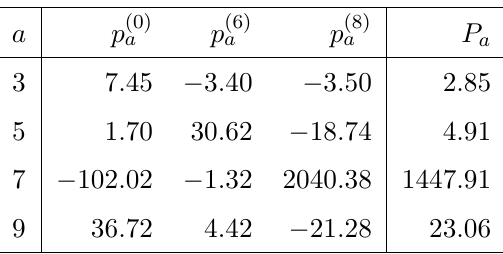
Table 12. Values of the coe(cid:14)cients entering the semi-numerical formula of " 0 =" in eq. (C.29). The last column gives P a for B (1 = 2)